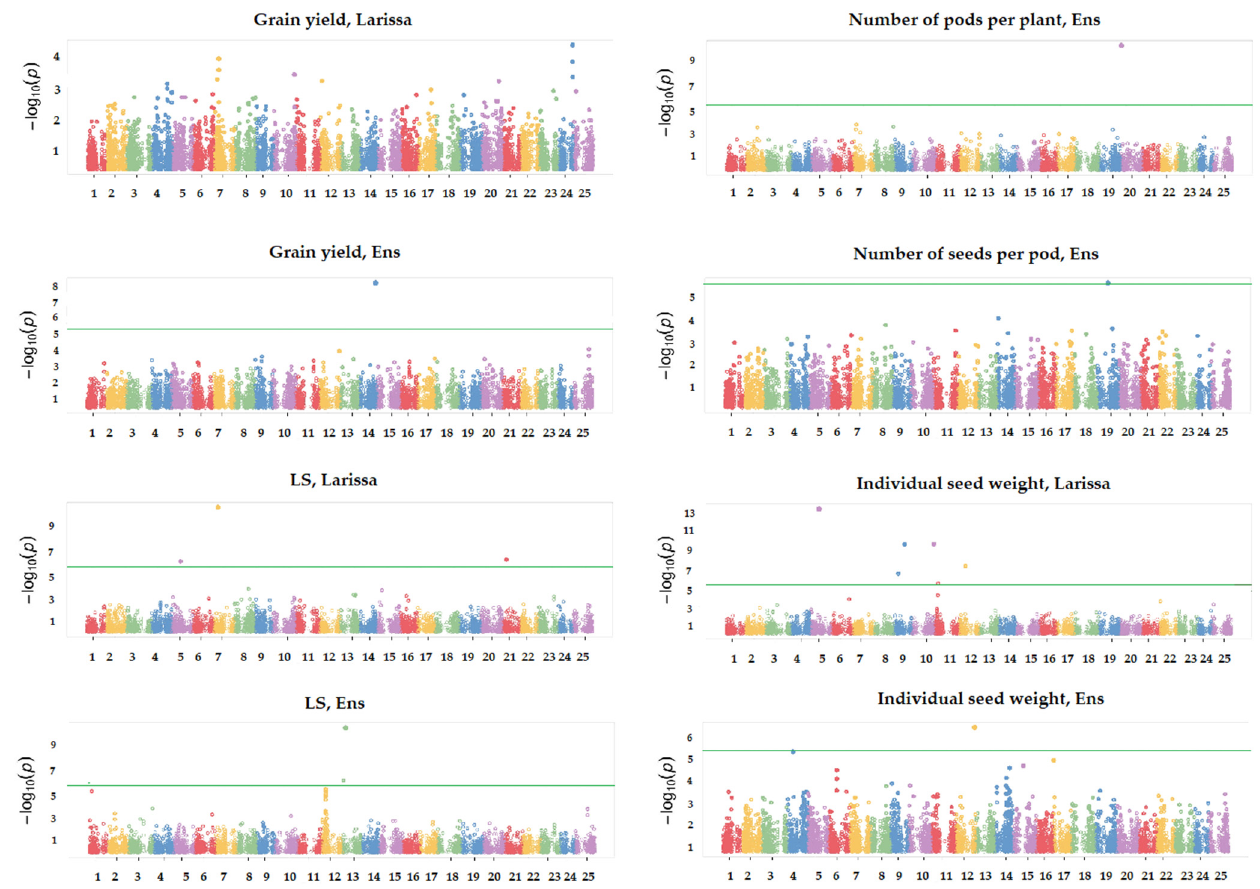
Figure 2. Manhattan plots showing the association scores of 9815 SNPs with grain yield, the average value of a visual lime susceptibility (LS) score, and two grain yield components featuring significant associations, for white lupin lines grown in Larissa (Greece) and Ens (The Netherlands). The continuous line represents Bonferroni’s threshold at p < 0.01.